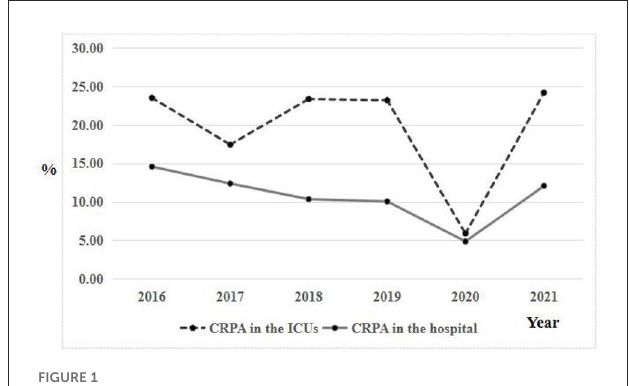
FIGURE1 Comparison of trends in carbapenem resistance in the ICUs and all hospital wards from 2016 to 2021.